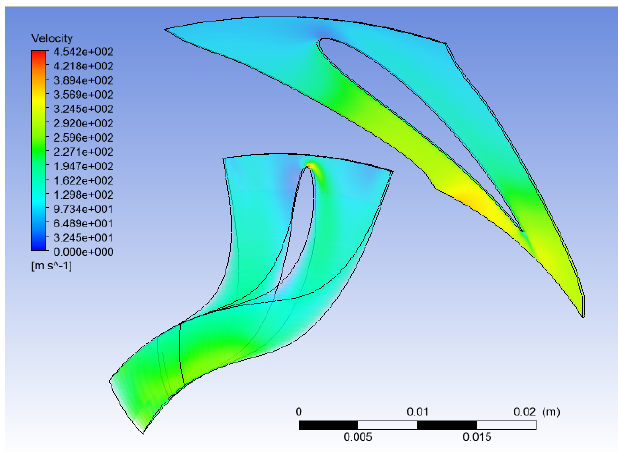
Figure 29. CFD study results: Velocity volume